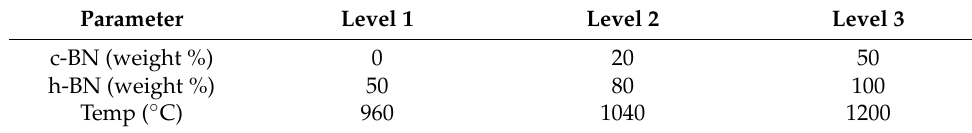
Table 4. Parameter selection for L27 orthogonal array Taguchi design: DOE.